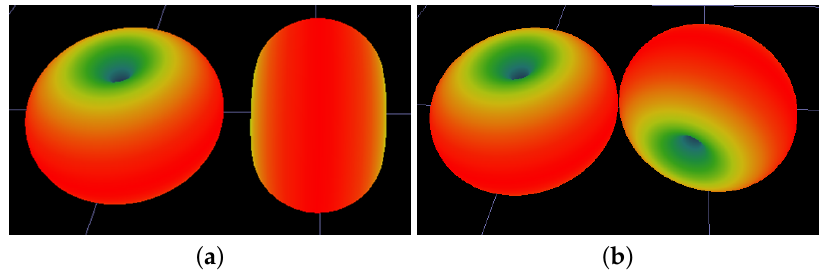
Figure 2. Typical antenna orientation set-ups: Part 2. ( a ) Tx-01 Vertical -Horizontal 0deg; ( b ) Tx-01 Vertical -Horizontal